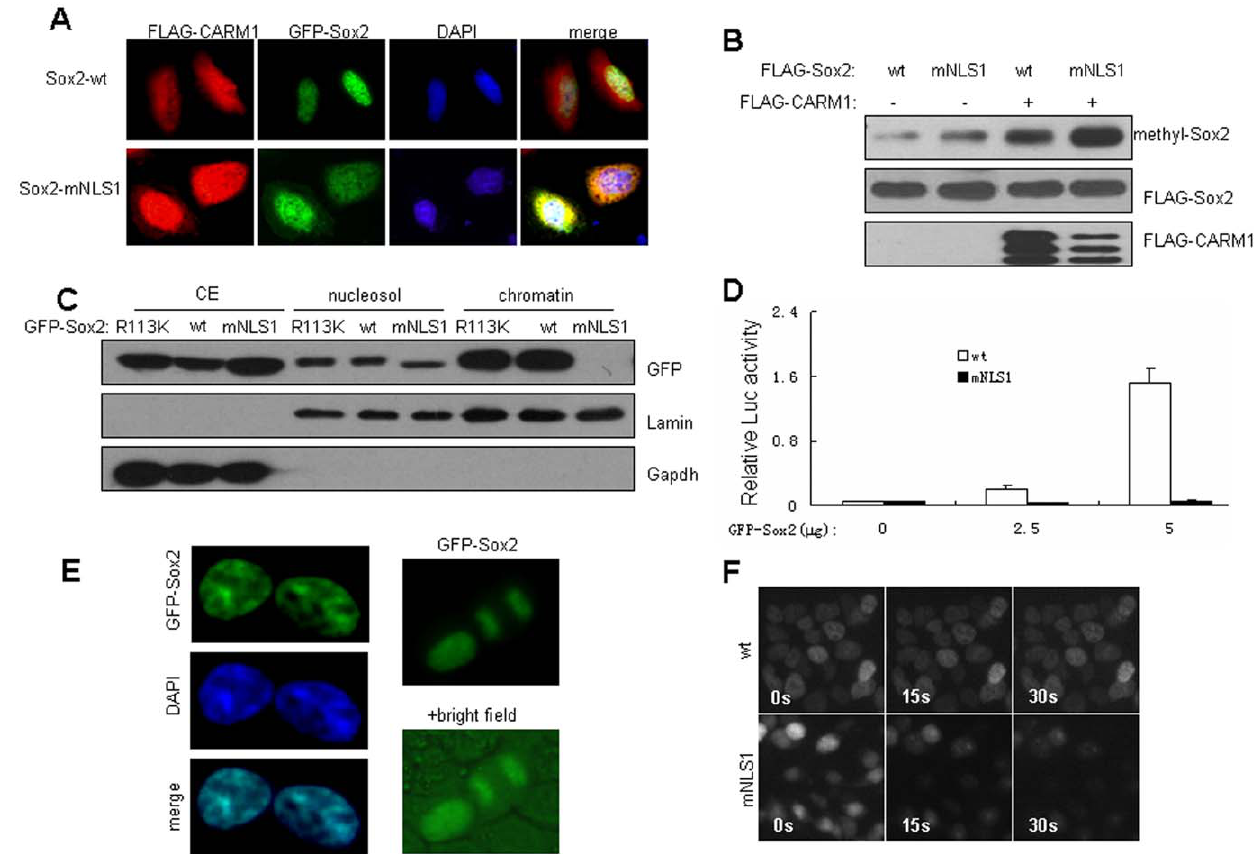
Figure 5. The role of NLS1 in CARM1-mediated Sox2 methylation. (A) Wild-type and mNLS1 of GFP-Sox2 were overexpressed in MCF7 cells together with FLAG-CARM1. Red, CARM1 immunostained with anti-FLAG antibody; green, GFP-Sox2; blue, DNA. Upper panel: GFP-Sox2-wt; lower panel: GFP-Sox2-mNLS1. (B) The impact of the NLS1 mutation on Sox2 methylation. (C) The distribution of Sox2 derivatives in MCF7 cell fractions. CE: cytoplasmic extracts; nucleosol: soluble nuclear materials; chromatin: extracts from unsoluble chromatin pellets with 500 mM NaCl. (D) Transactivation activity of GFP-Sox2-mNLS1 in MCF7 cells. The wild-type GFP-Sox2 was used as a control. ** P , 0.01, Student’s t -test. (E) Tight association of Sox2 with chromatin in MCF7 cells. Left: The subcellular localization of wild-type GFP-Sox2; right: GFP-Sox2 bound to chromosomes in mitosis (picture at the bottom indicates the overlap of GFP-Sox2 and the background under bright field microscopy). (F) Chromatin retention of GFP- Sox2. MCF7 cells expressing GFP-Sox2-wt or GFP- Sox2-mNLS1 were permeabilized with 0.3% NP-40. Sequential images were captured before and after permeabilization. information Figure S1. Site-directed mutagenesis of the Sox2 expression plasmids was conducted according to Stratagene’s protocol (Stratagene QuikChange Site-directed Mutagenesis kit).